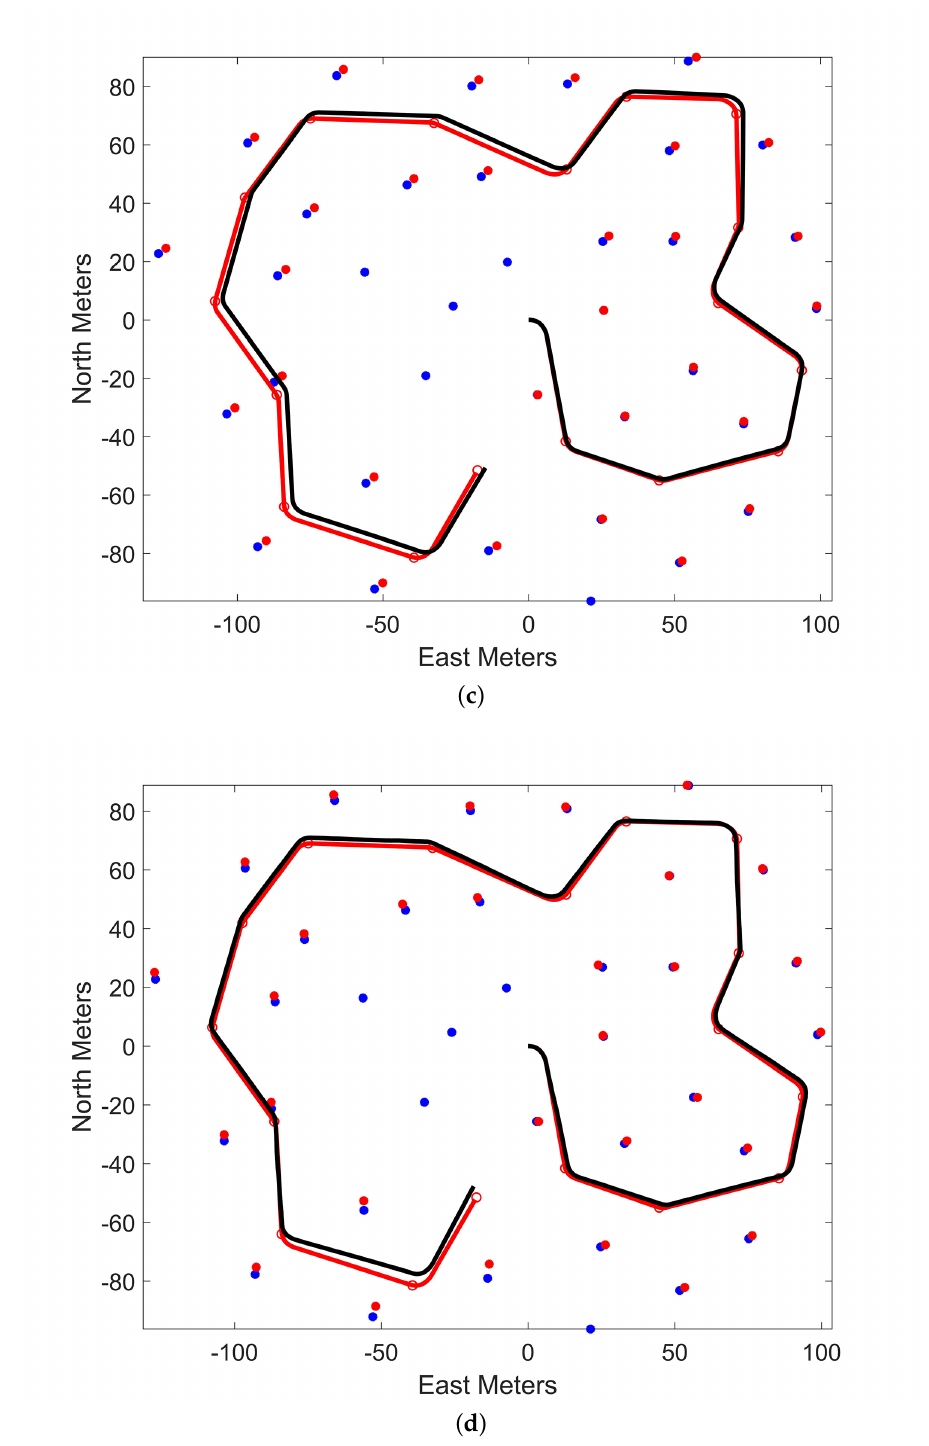
Figure 6. The simulation result of four SLAM algorithms. ( a ) FastSLAM. ( b ) Particle swarm optimisation (PSO)-FastSLAM. ( c ) Adaptive generic FastSLAM algorithm